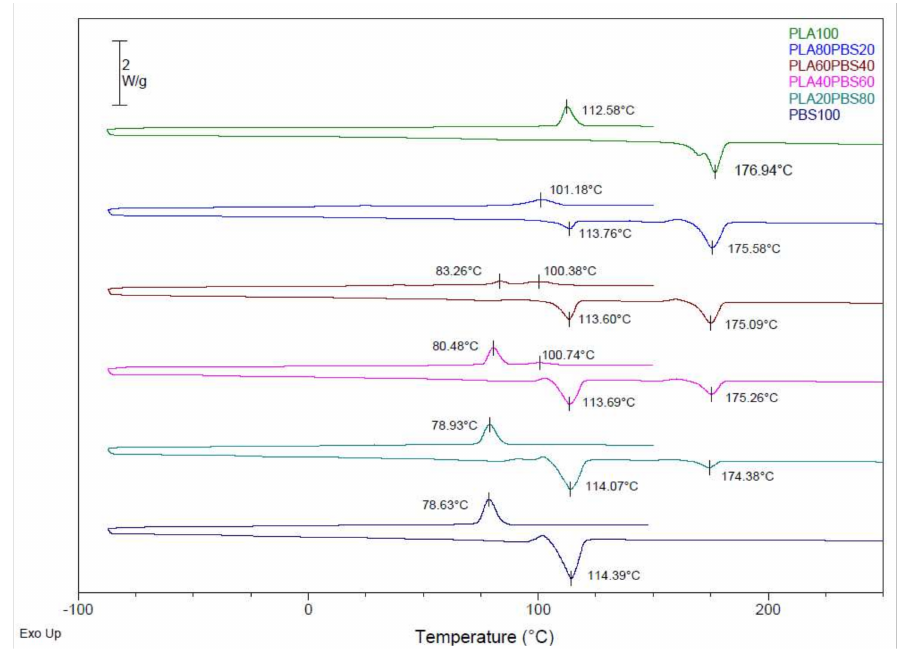
Figure 1. DSC curves of PLA/PBS blends. Table 3. Transition temperature and crystallinity of PLA/PBS